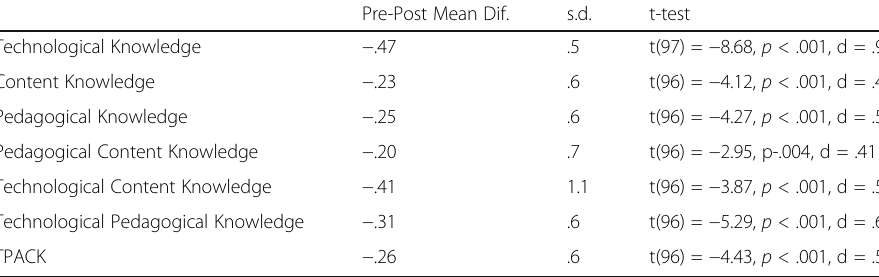
Table 3 Descriptive and inferential statistics for TPACK mean differences before and after the training course of ( N = 98) ASPETE undergraduates Pre-Post Mean Dif.